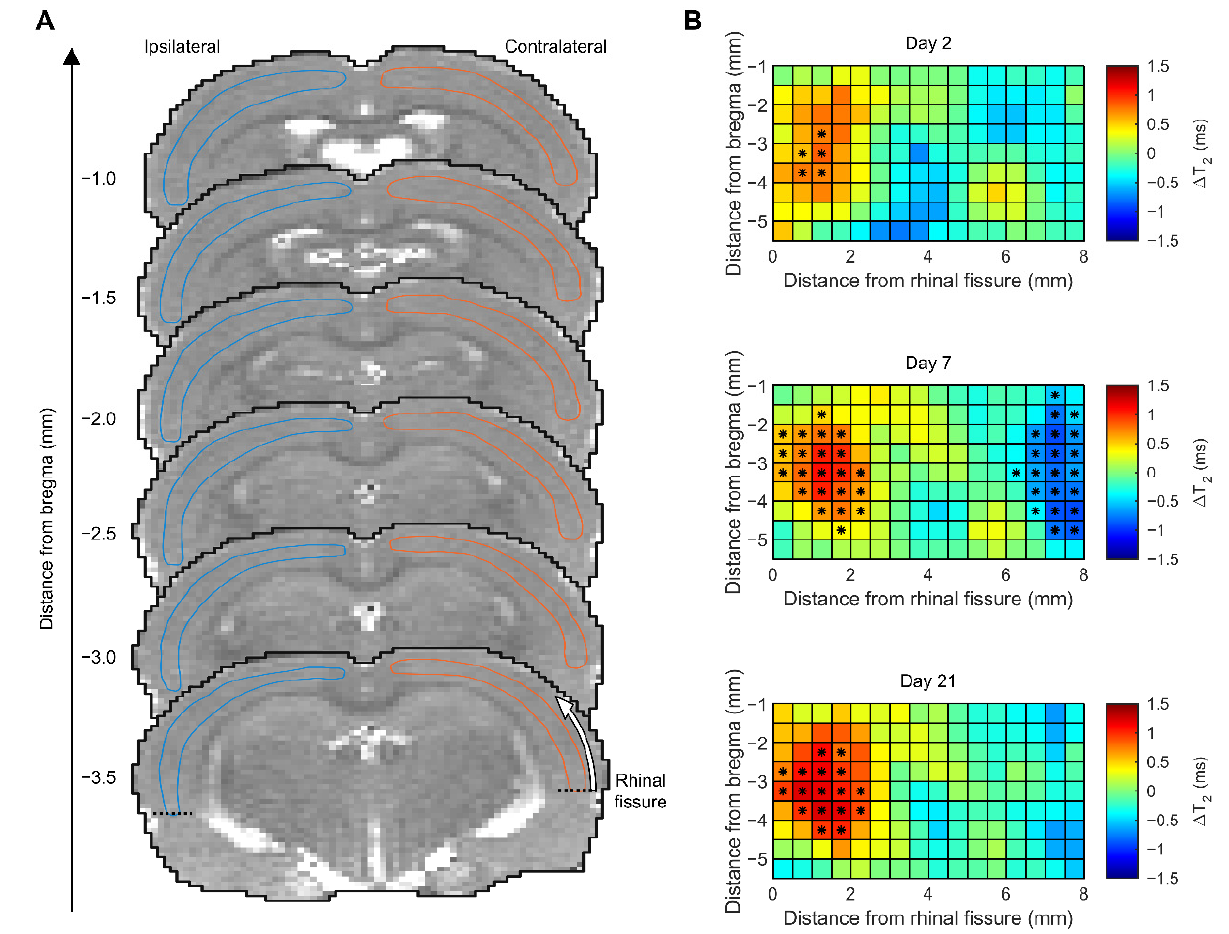
Figure 8. Cortical T 2 magnetic resonance imaging (MRI) analysis in the sham-operated experimental control group. ( A ) T 2 images of the sham animals were registered to a template brain. Then, the ipsilateral (left, blue outline) and the contralateral (right, orange outline) cortex was manually outlined in each image slice (thickness 0.5 mm). In each slice, a cortical profile of the T 2 relaxation time was measured, starting at the rhinal fissure and continuing dorsally towards the brain midline as indicated by the white arrow (bottom slice). ( B ) The cortical T 2 profiles of different slices were combined, filtered using a 2-dimensional isotropic Gaussian filter with a standard deviation of 0.5 mm, and interpolated on a grid with a 0.5 × 0.5 mm 2 resolution. We found an ipsilateral signal increase on D2, D7, and D21 in areas close to the rhinal fissure at the rostrocaudal level (-3.5 mm from the bregma) as the median of the ipsilateral T 2 area was increased compared with that contralaterally. We also found a parasagittal signal decrease on D7. Color coding of the heatmap: red indicates a positive ipsilateral vs. contralateral difference in T 2 (higher T 2 ipsilaterally), and blue indicates a negative difference (higher T 2 contralaterally). An asterisk (*) at a given grid point indicates a statistically significant difference for the median T 2 (Mann-Whitney U-test, after correcting for multiple comparisons using the Benjamini-Hochberg procedure with an average false discovery rate of